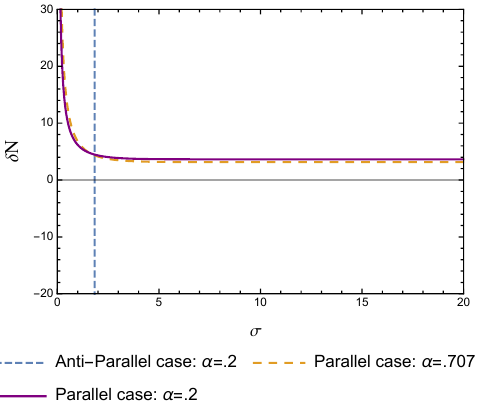
Figure 23 . Parallel and Anti-parallel motions in (1 + 1) dimensions with thermal background: δ N Vs σ plot with ∆ E = 1 , A = 10 a B